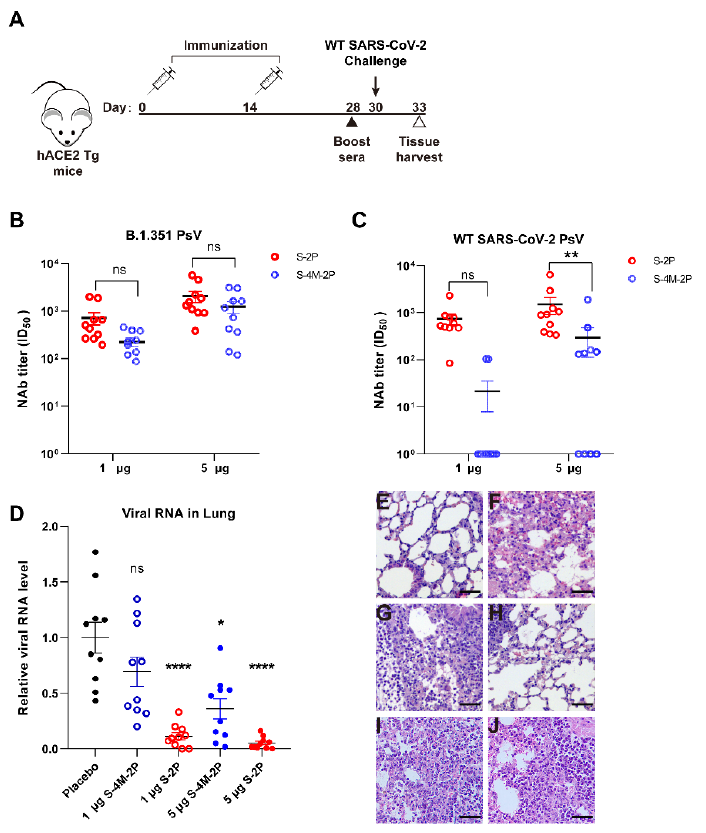
Figure 5. Protective efficacy of SARS ‐ CoV ‐ 2 spike proteins against wild ‐ type SARS ‐ CoV ‐ 2 challenge in hACE2 transgenic mice. Groups of hACE2 transgenic mice ( n = 10) received two doses of 1 μ g or route. Mice were challenged with 1 × 10 5 FFU of live SARS ‐ CoV ‐ 2 virus at 30 days post initial vac ‐ cination. ( A ) Schematic diagram of mouse immunization and challenge schedule. Boost sera col ‐